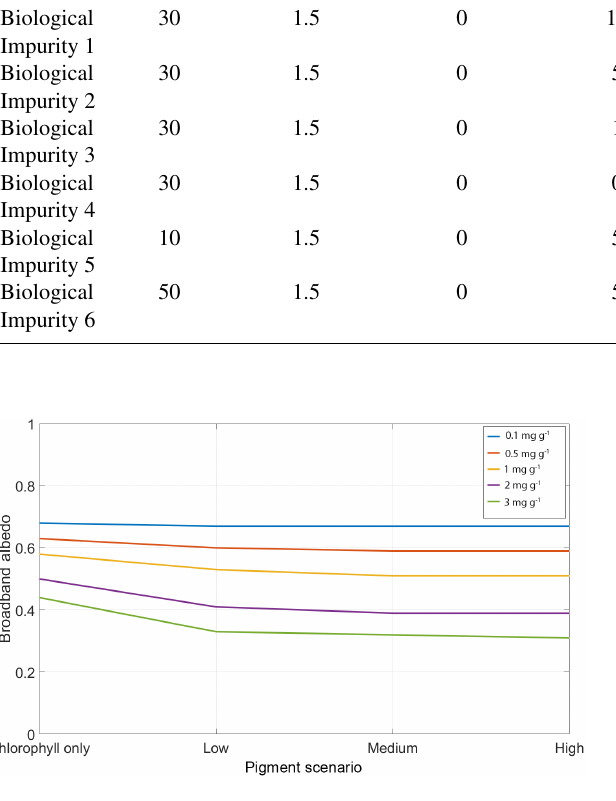
Figure A1. Broadband albedo against pigment scenario. In all sim- ulations the ice crystal size was 1500µm, the solar zenith angle was 60 ◦ and the impurities were confined to a 3mm surface layer. There was no dust or black carbon. The biological impurities had cell radii of 15µm. The pigment scenarios are as follows: chloro- phyll only is 1.5% chlorophyll a ; low is 1.5% chlorophyll a , 1% secondary carotenoids; medium is 1.5% chlorophyll a , 5 % sec- ondary carotenoids; high is 1.5% chlorophyll a , 10% secondary carotenoids. The legend shows the biomass concentration of algal cells in the upper 3mm